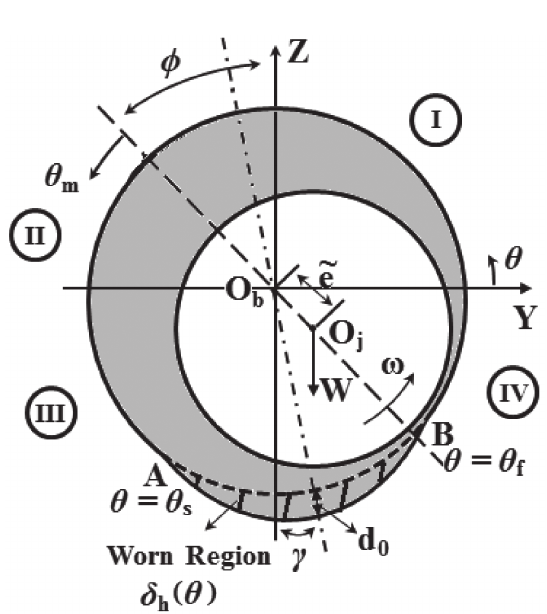
Figure 5 - Worn bearing